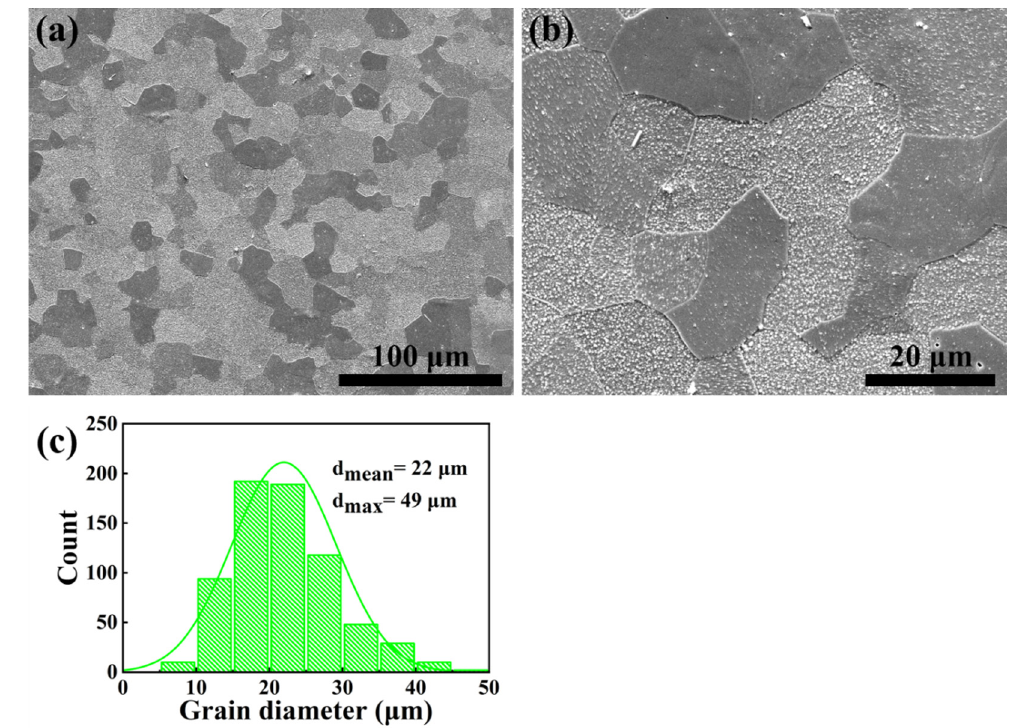
Figure 5. SEM secondary electron images of ( a ) macrostructure, ( b ) microstructure and ( c ) grain diameter statistical histogram of the as-TMTed sample.